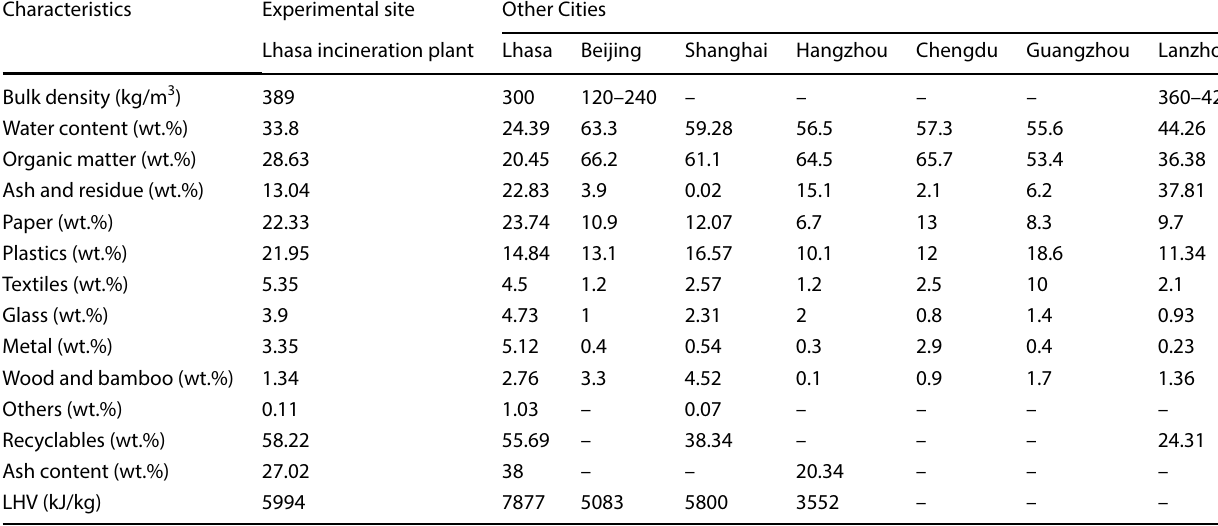
Table 3 Physical characteristics of municipal solid waste